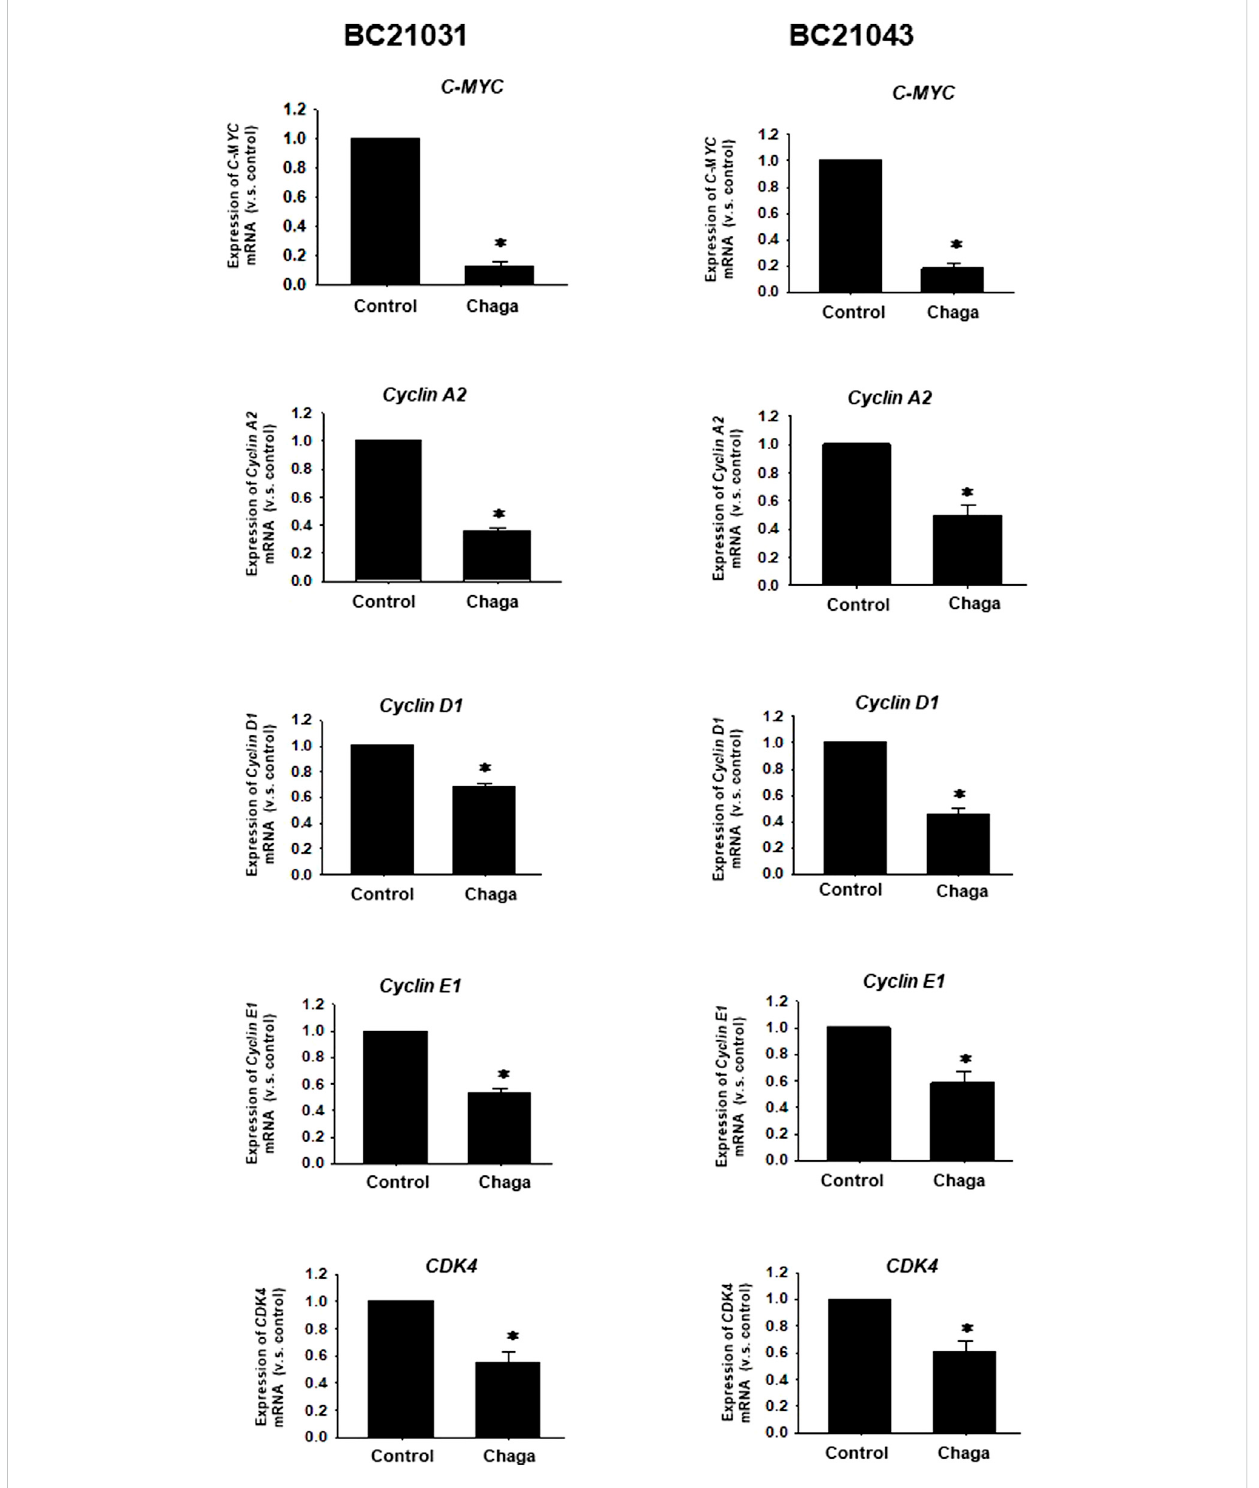
FIGURE 5 Effects of Chaga on mRNA expression levels of C-MYC and cell cycle-related genes in DBCO. mRNA expression of C-MYC, Cyclin A2 , Cyclin D1 , Cyclin E1, and CDK4 was determined by quantitative real-time PCR. The expression level of each gene was quanti fi ed based on the ratio of expression level to GAPDH and shown as a fold increase relative to control (n = 4). Results were expressed as mean ± S.E.M. * p < .05 vs.